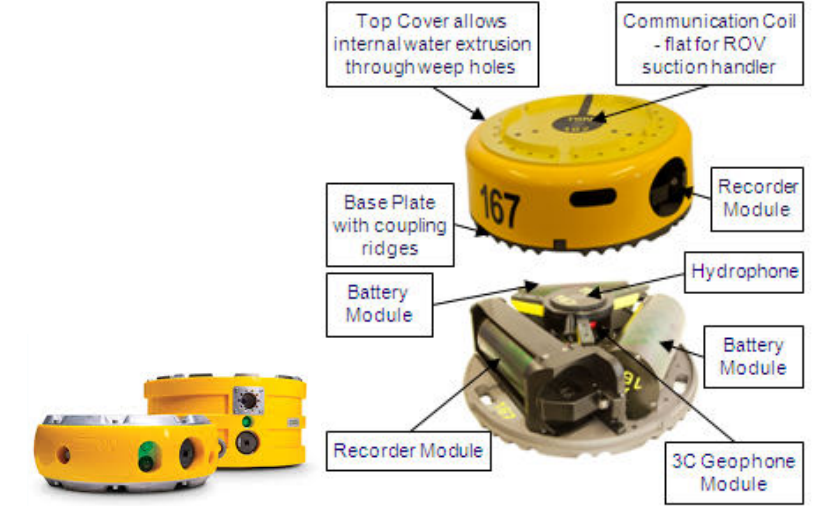
Sensors 2018 , 18 , 3446 Figure 28. The OBSs with various outer casings. Figure 28. The OBSs with various outer casings.